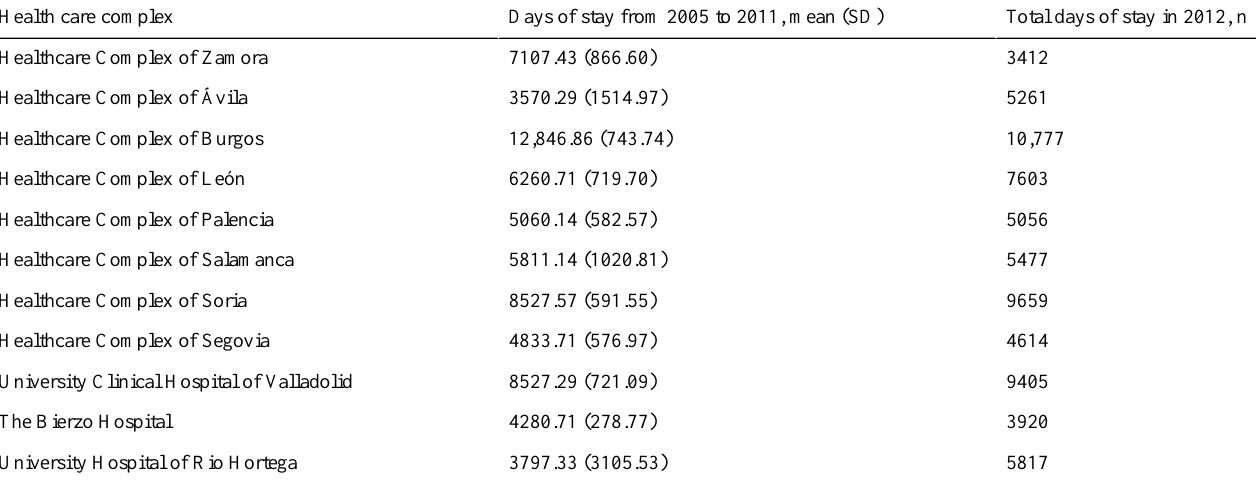
Table 4. Mean days of stay in the period from 2005 to 2011 compared to the total days of stay from the year 2012 for each hospital.